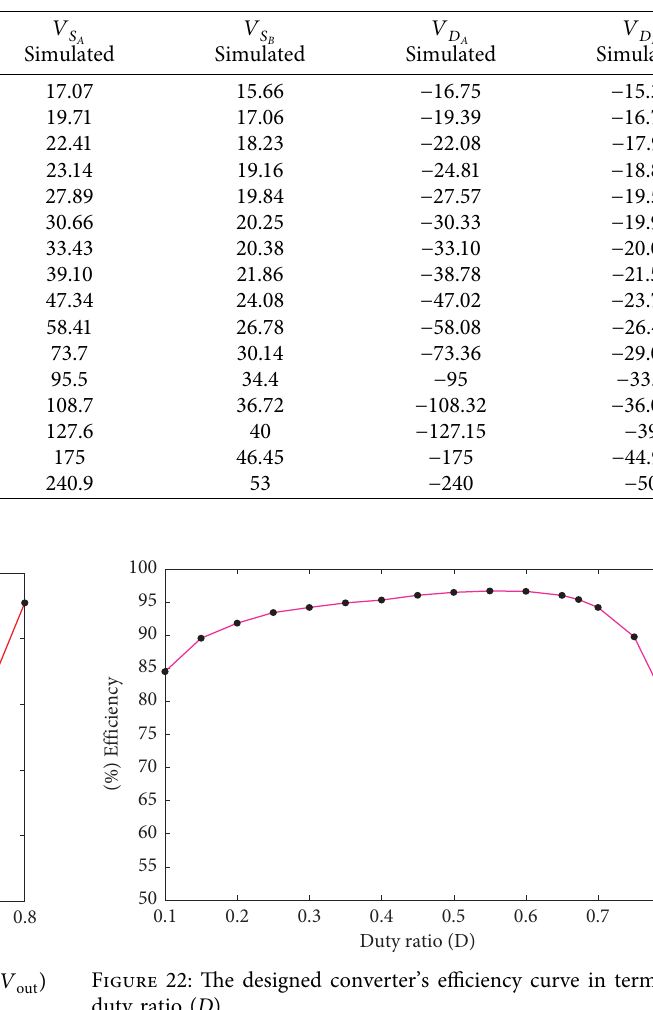
Table 4: Active and passive switching voltage stresses.